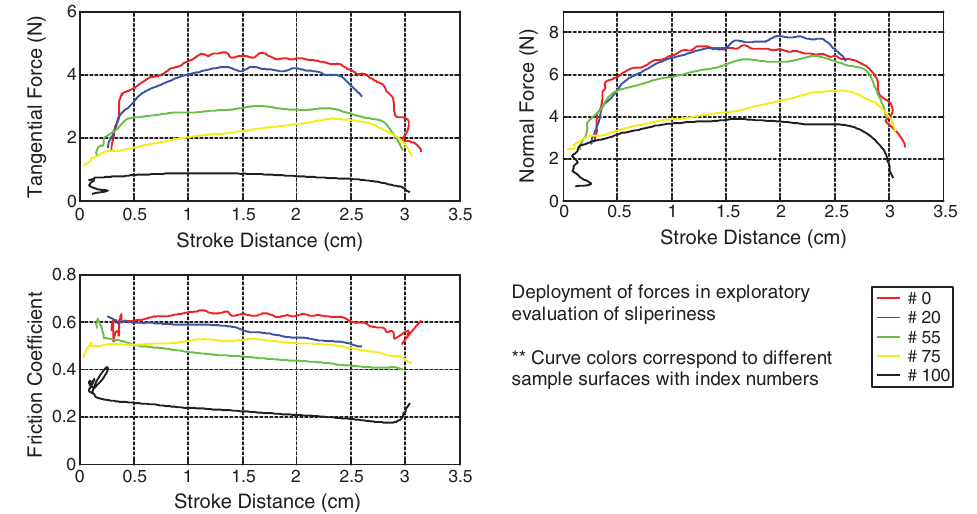
** Curve colors correspond to different sample surfaces with index numbers